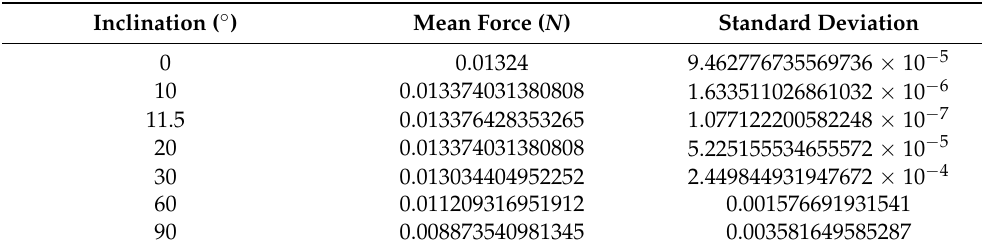
Table 7. Means and standard deviations of Lorentz force at varying